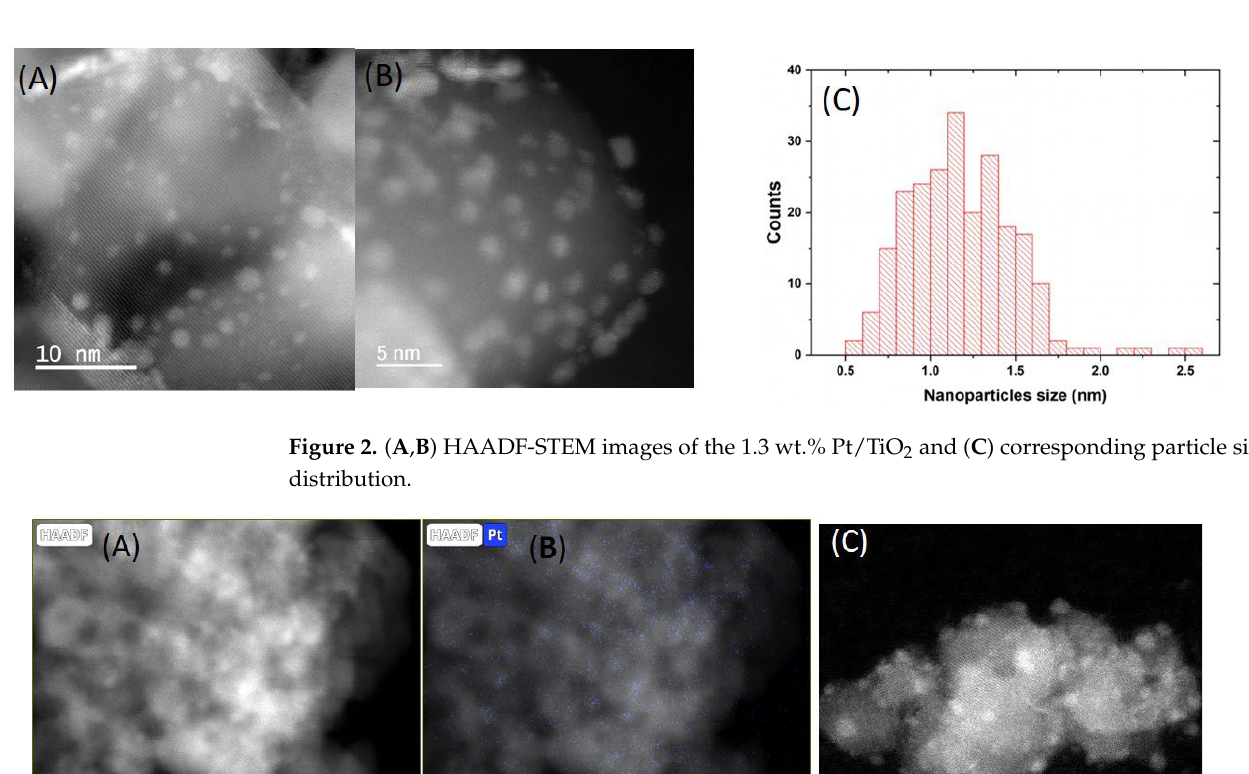
Figure 2. ( A , B ) HAADF-STEM images of the 1.3 wt.% Pt/TiO 2 and ( C ) corresponding particle size distribution.